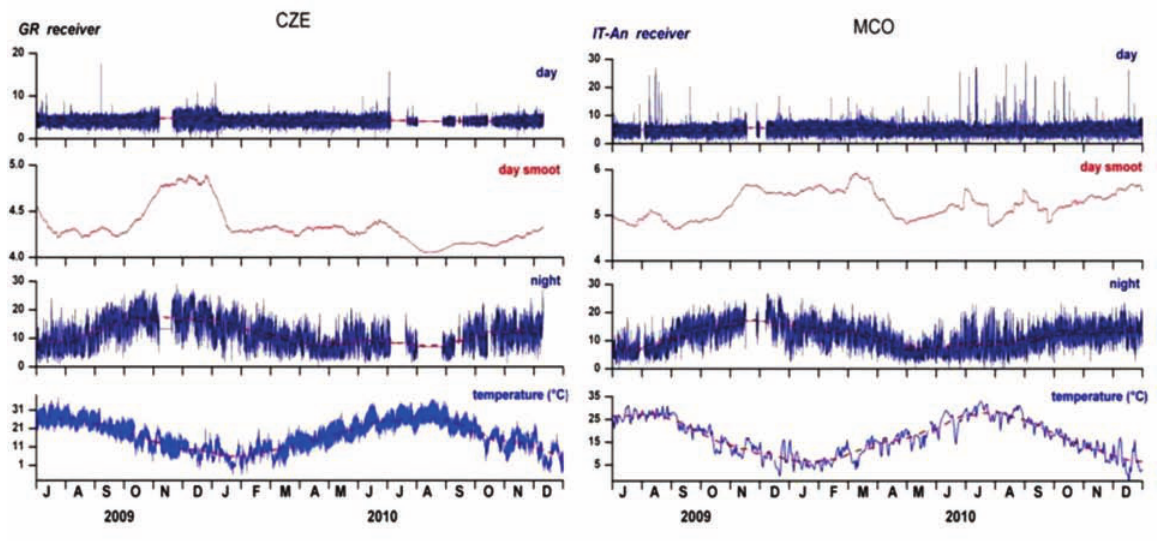
Figure 3. Day-time and night-time transmitter radio signals and local air temperature trends collected from July 2009 to December 2010. Left: Intensities of the CZE (270 kHz) transmitter signals collected by the GR receiver (Figure 1). Right: Intensities of the MCO (216 kHz) transmitter signals collected by the IT-An receiver (Figure 1). The local air temperature trends are also reported for both. Red dashed lines, long-term smoothed data. The second panels from the top show the 30-day adjacent averaging smoothing of the day-time radio